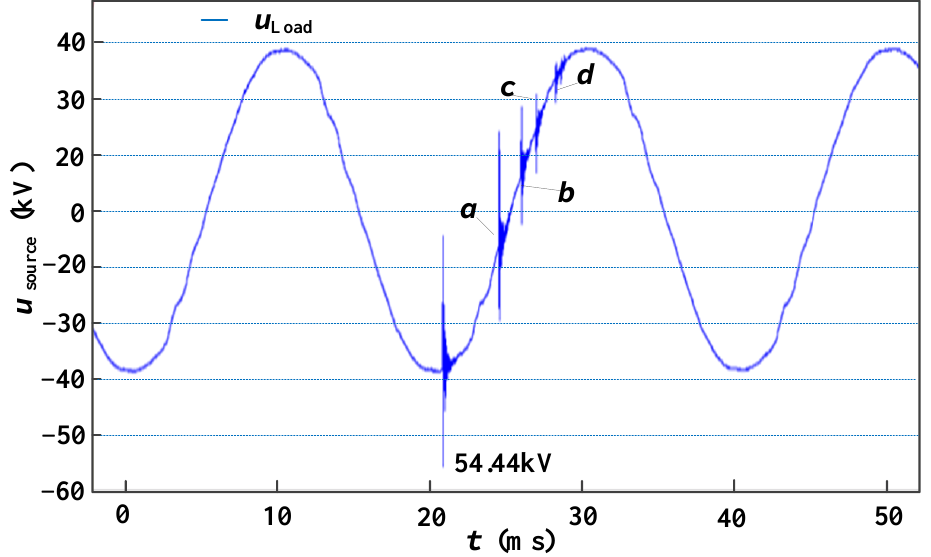
Figure 19. Operating overvoltage in the closing process when the phase angle is − 90°. The overvoltage has a higher frequency oscillation process, and the highest oscillation frequency exceeds 0.1 MHz (as shown in Figure 20).